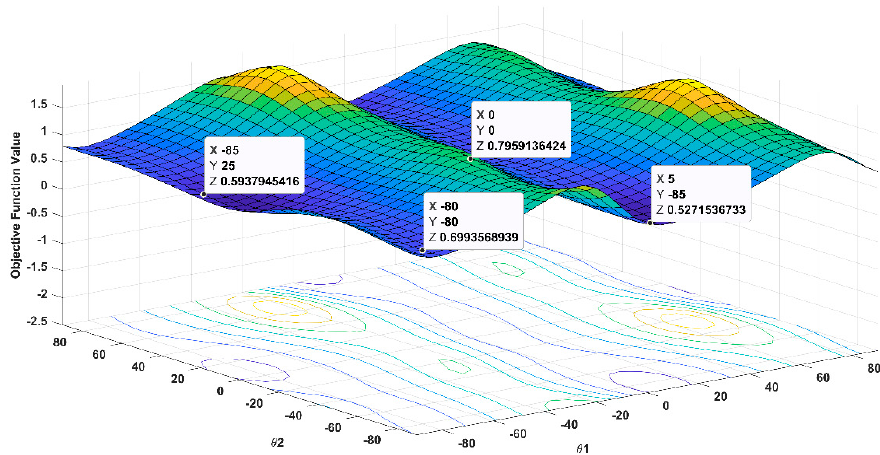
Figure 3. Optimization function as a function of θ 1 , θ 2 for D2 and E2 sets with ply thickness of t 1 = t 2 = 0.4 mm.